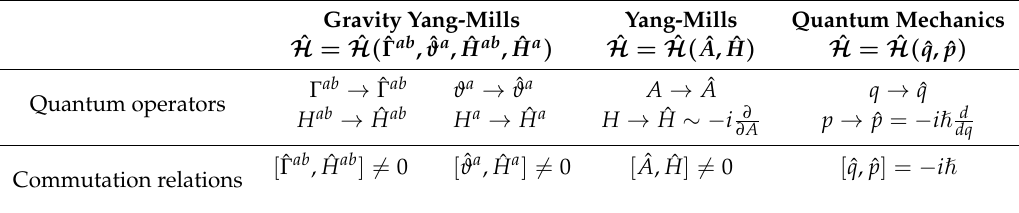
Table 2. The analogies between canonical quantization in quantum mechanics and in the exterior calculus approach to Yang-Mills theories and gauge theories of gravity (` a la